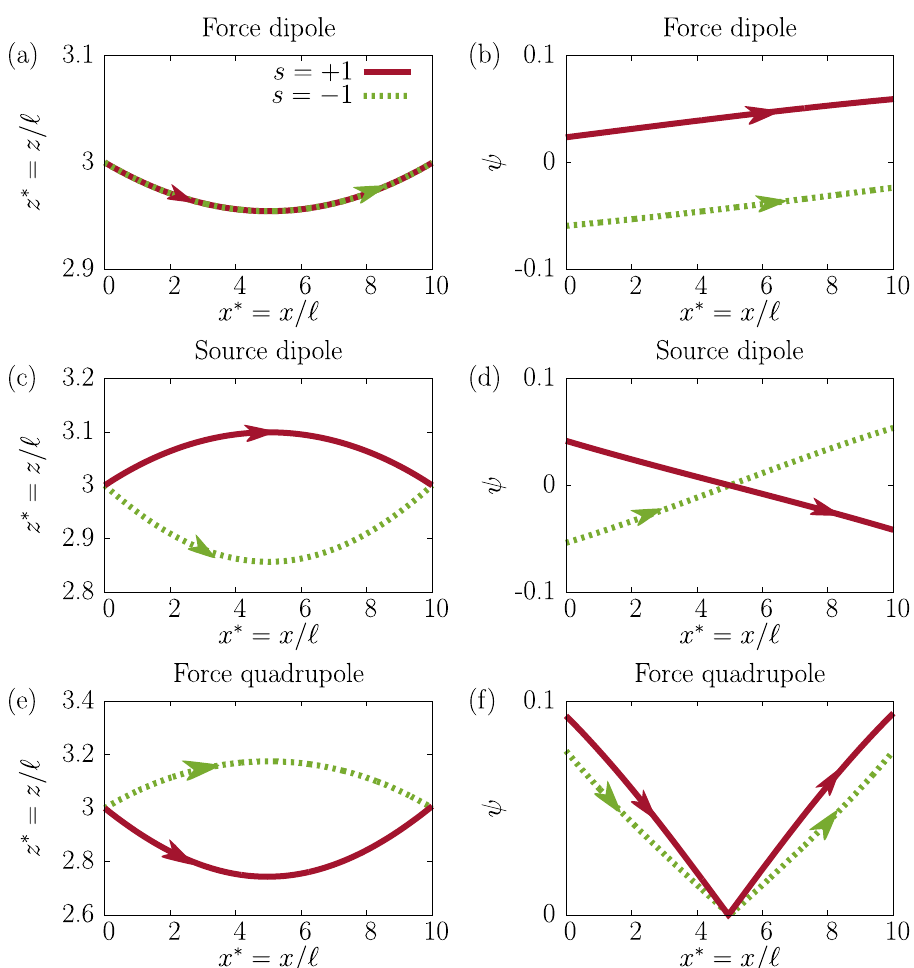
Fig. 2 Optimal 2D microswimmer trajectories near a hard and in fi nitely extended wall. Exemplary trajectories minimizing traveling times between r (cid:1) A ¼ ð 0 ; 0 ; 3 Þ and r (cid:1) B ¼ ð 10 ; 0 ; 3 Þ are presented together with the corresponding steering angles for force dipole swimmers ( a and b ), source dipole swimmers ( c and d ), and force quadrupole swimmers ( e and f ). Lengths are made dimensionless by ℓ representing the distance at which the effect of hydrodynamic interactions becomes important. The swimming trajectories take place in the xz -plane. Red solid and green dashed lines correspond to positive ( s = 1) and negative ( s = − 1) singularity coef fi cient,